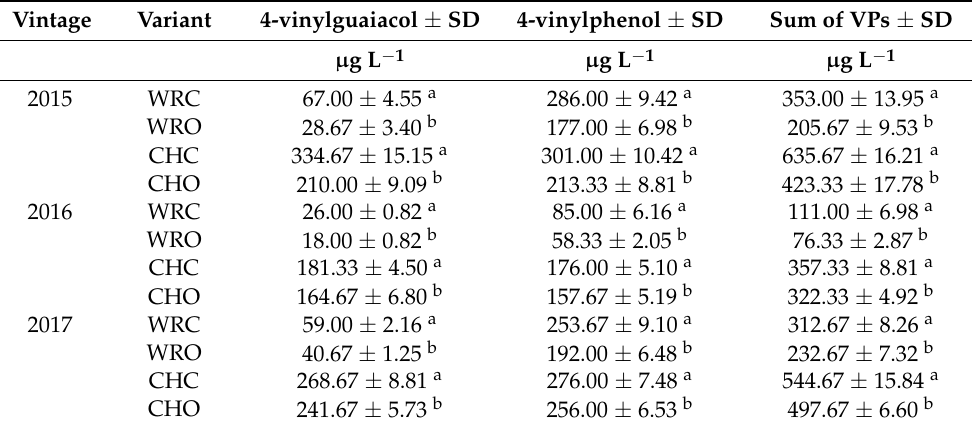
Figure 2. Results of sensory evaluation of individual variants of the Welschriesling and Chardonnay varieties based on the 100-point system according to STN EN ISO 8586, vintages 2015–2017. Note: WRC—Welschriesling control variant; WRO—Welschriesling variant with targeted must oxygenation; CHC—Chardonnay control variant; CHO—Chardonnay variant with targeted must oxygenation. Table 3. The 4-vinylguaiacol, 4-vinylphenol, and sum of the volatile phenolics content in the experi- mental variants in vintages